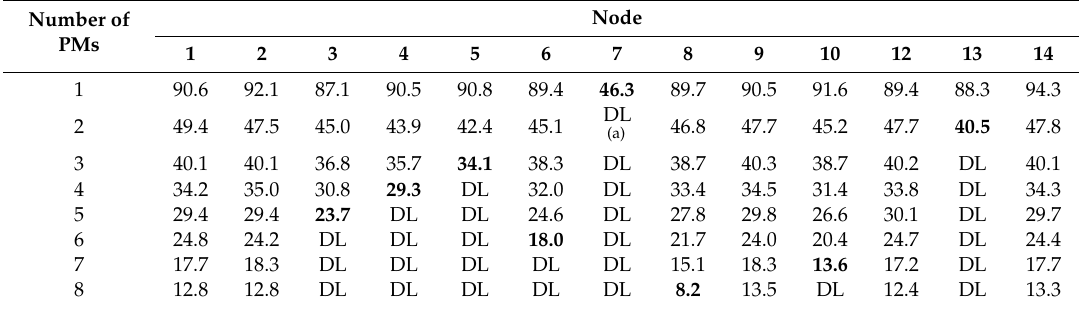
Table 2. Sensitivity index as a percentage of the total power of the Vittorio Emanuele feeder when the power measurements (PMs) are moved between nodes. Number of PMs